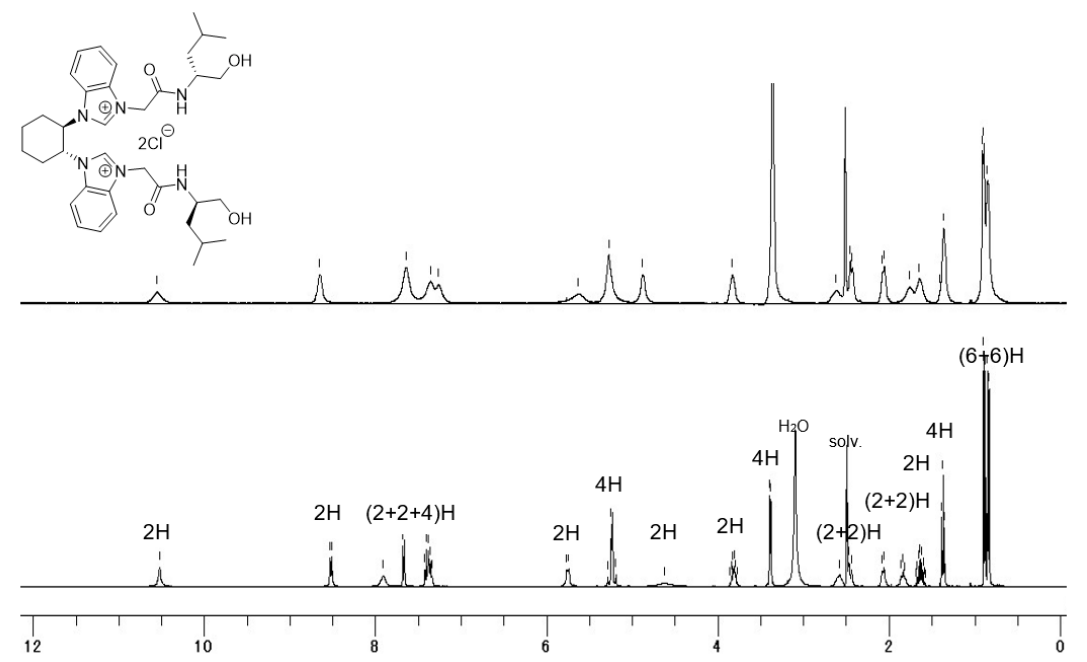
Figure 2. 1 H NMR spectrum of ( R , R ; R , R )- L1 in (CD 3 ) 2 SO at 25 ◦ C (upper) and 80 ◦ C (lower).